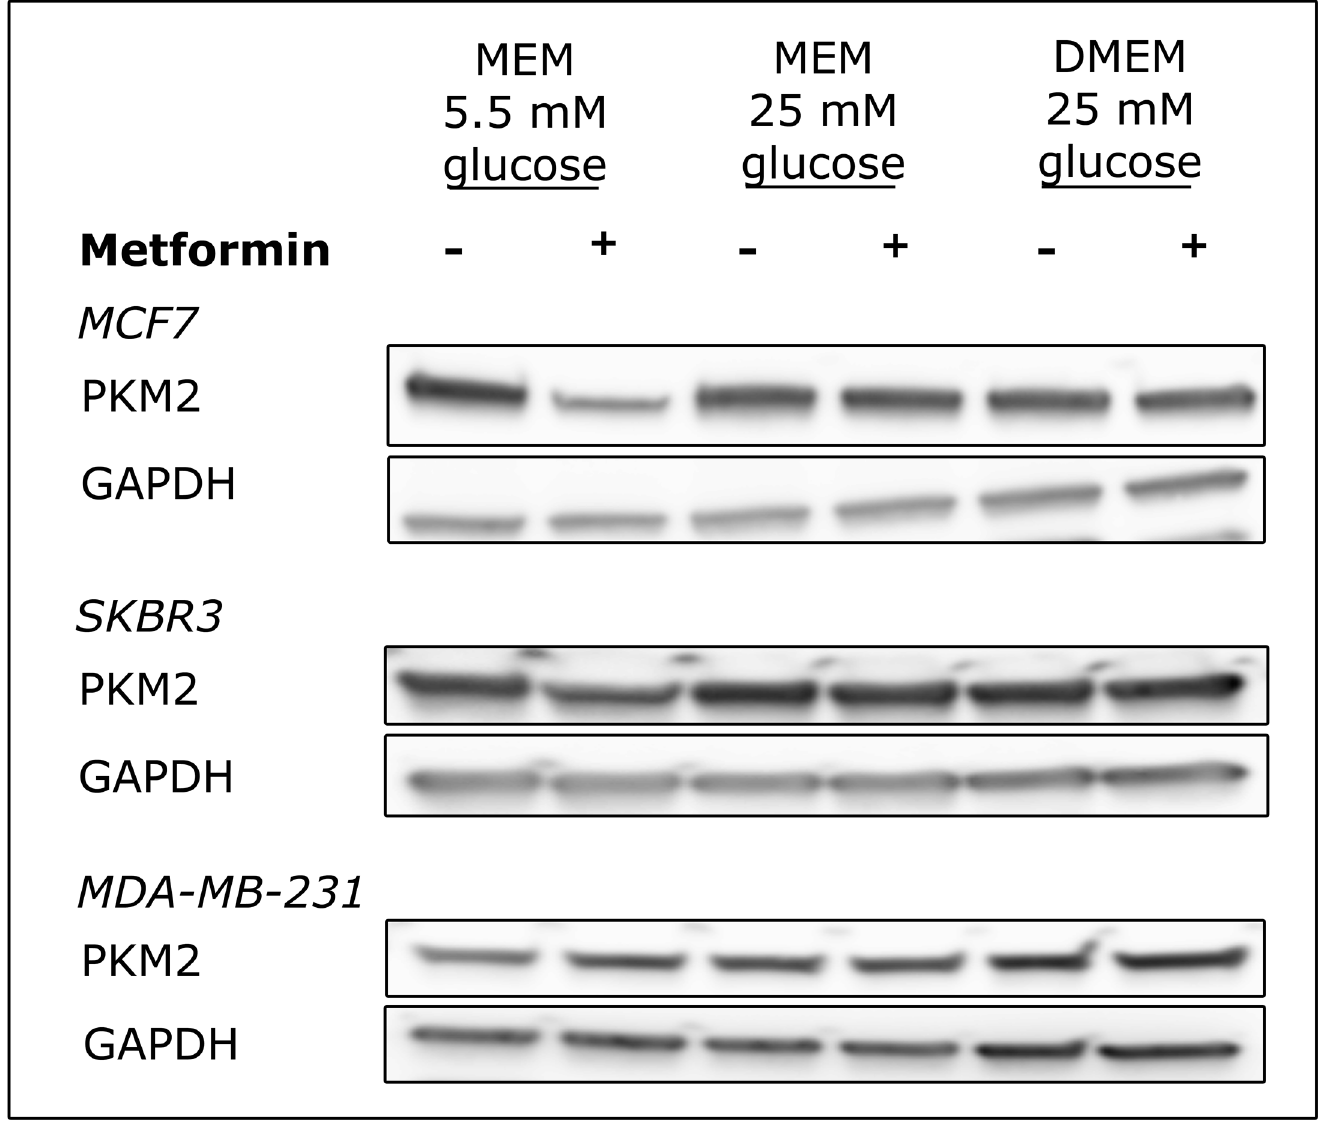
Fig 5. Metformin treatment induces a glucose-sensitive PKM2 downregulation in MCF7 and SKBR3 cells. MCF7, SKBR3 and MDA-MB-231 cells were plated at 8X10 5 cells/well in 6-well plates in MEM medium with 5.5 mM or 25 mM glucose or DMEM and were treated with 10 mM metformin. After 48, 36 and 48 hours, respectively cells were lysed and protein extracts were analysed by Western Blot with an anti-PKM2 antibody. GAPDH was used as loading